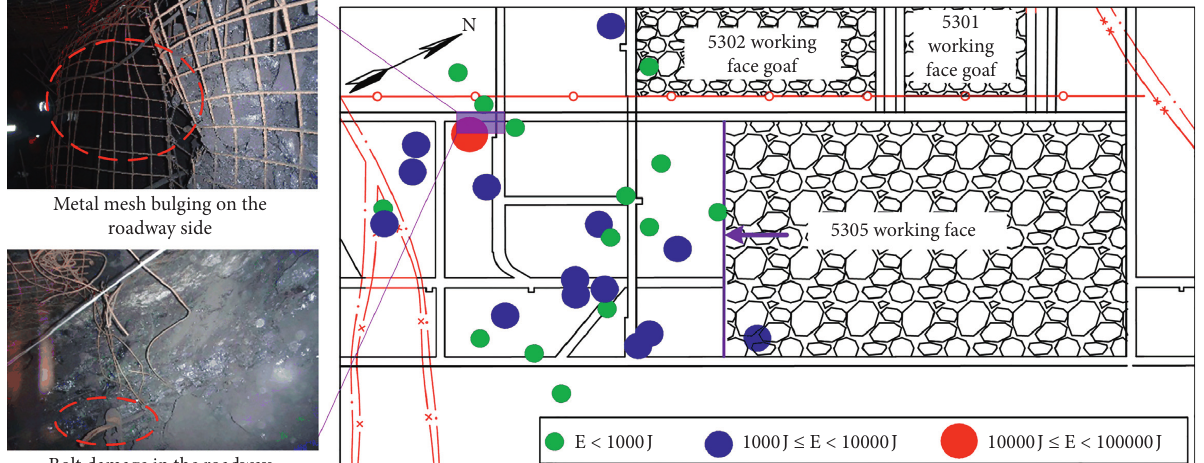
Figure 2: Situation of on-site damage induced by the rock